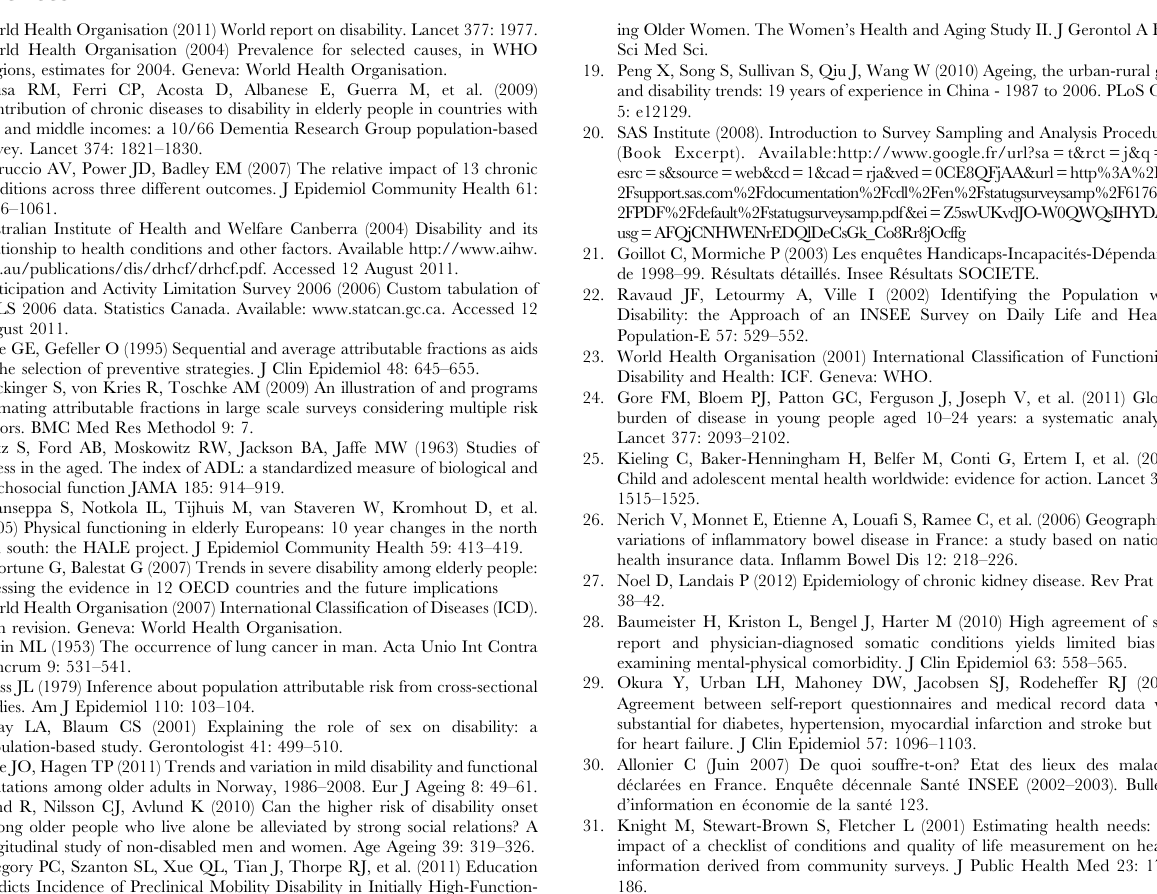
Table S1 Sociodemographic characteristics of the population in France for each chronic condition Table S2 Gross attributable fractions (AFs) for each chronic condition estimated for the different disability